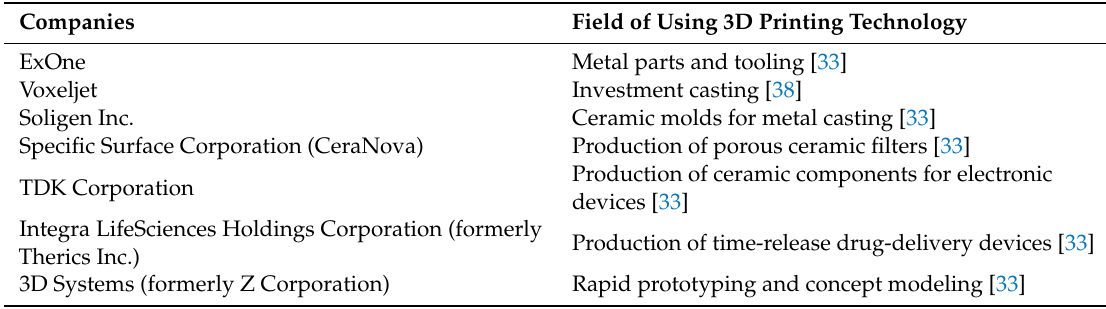
Table 1. Licensees by MIT for 3D printing technology.